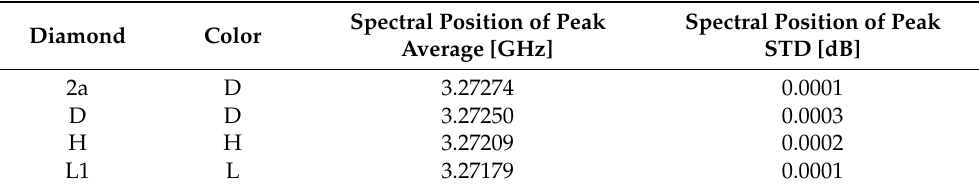
Table 6. Average and STD of the spectral peaks at frequencies range 3.15-5.95 GHz for different master diamonds.